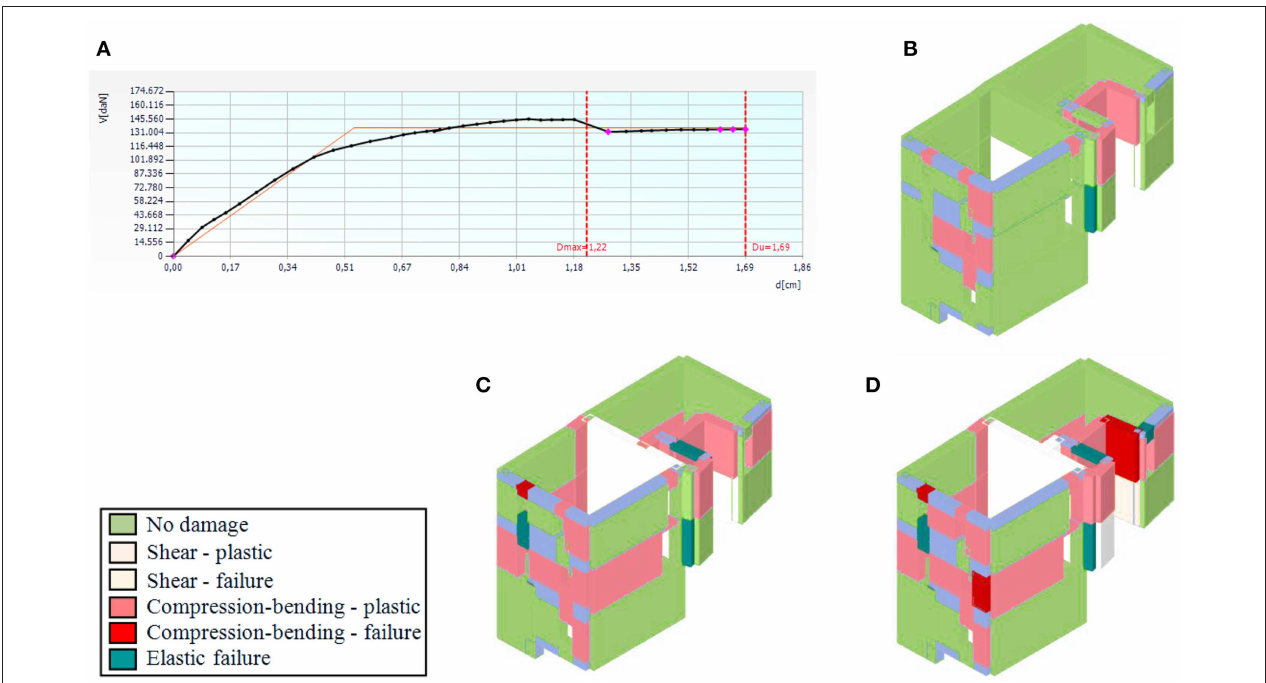
FIGURE 8 | Seismic behavior in direction X of the isolated S.U. type B: MDOF pushover curve (A) and damage patterns related to the conventional yielding limit (B) , maximum base shear (C), and ultimate displacement D u (D) .